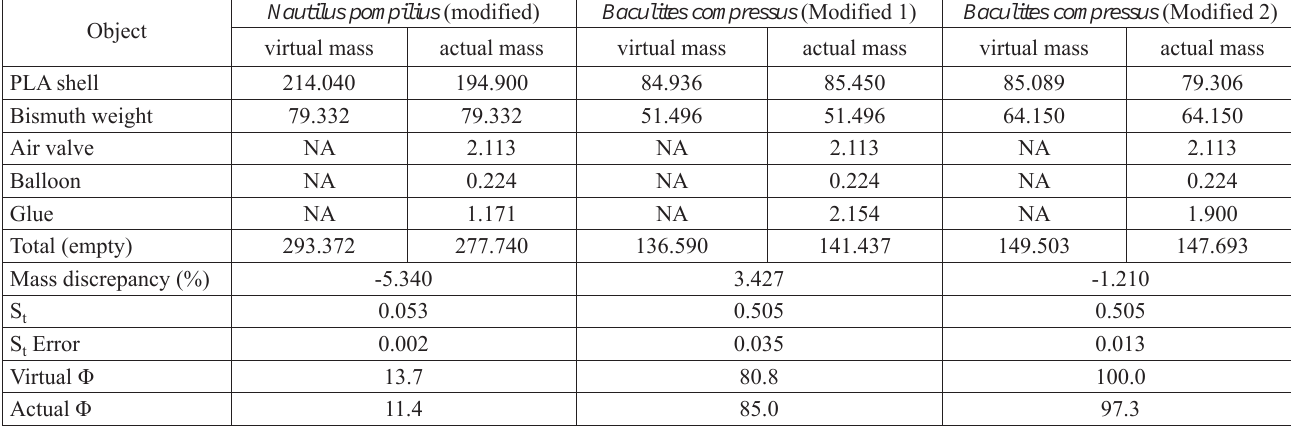
Table 5. Mass (in g) discrepancies between the modified virtual models with simple internal geometries and their 3D printed counterparts for each model component. The error in hydrostatic stabilities (S t ) were computed by assuming that the mass surplus or deficit was acting in the positive and negative z-directions only (representing maximum error in S t ). Φ , neutrally buoyant condition; NA, not